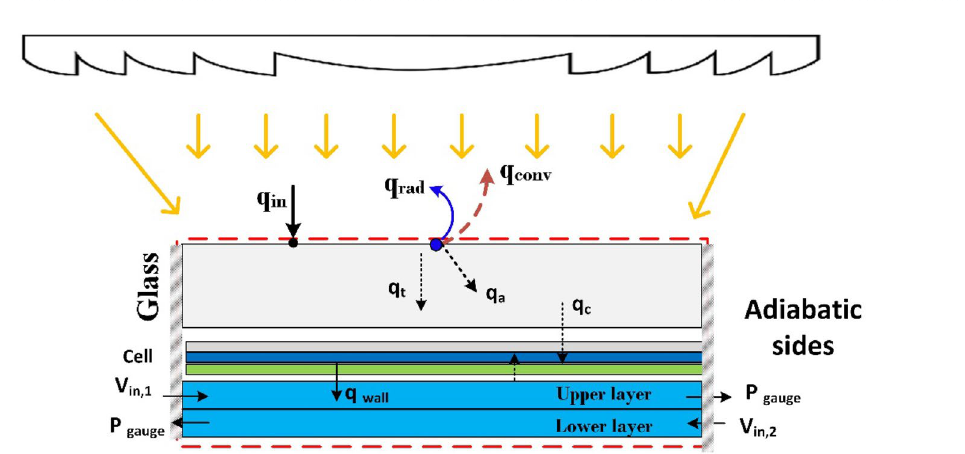
Figure 2. Two-dimensional boundary conditions for the DL-MCHS design where H1 and H2 are inlet and outlet top heights, H3 and H4 are inlet and outlet bottom heights.